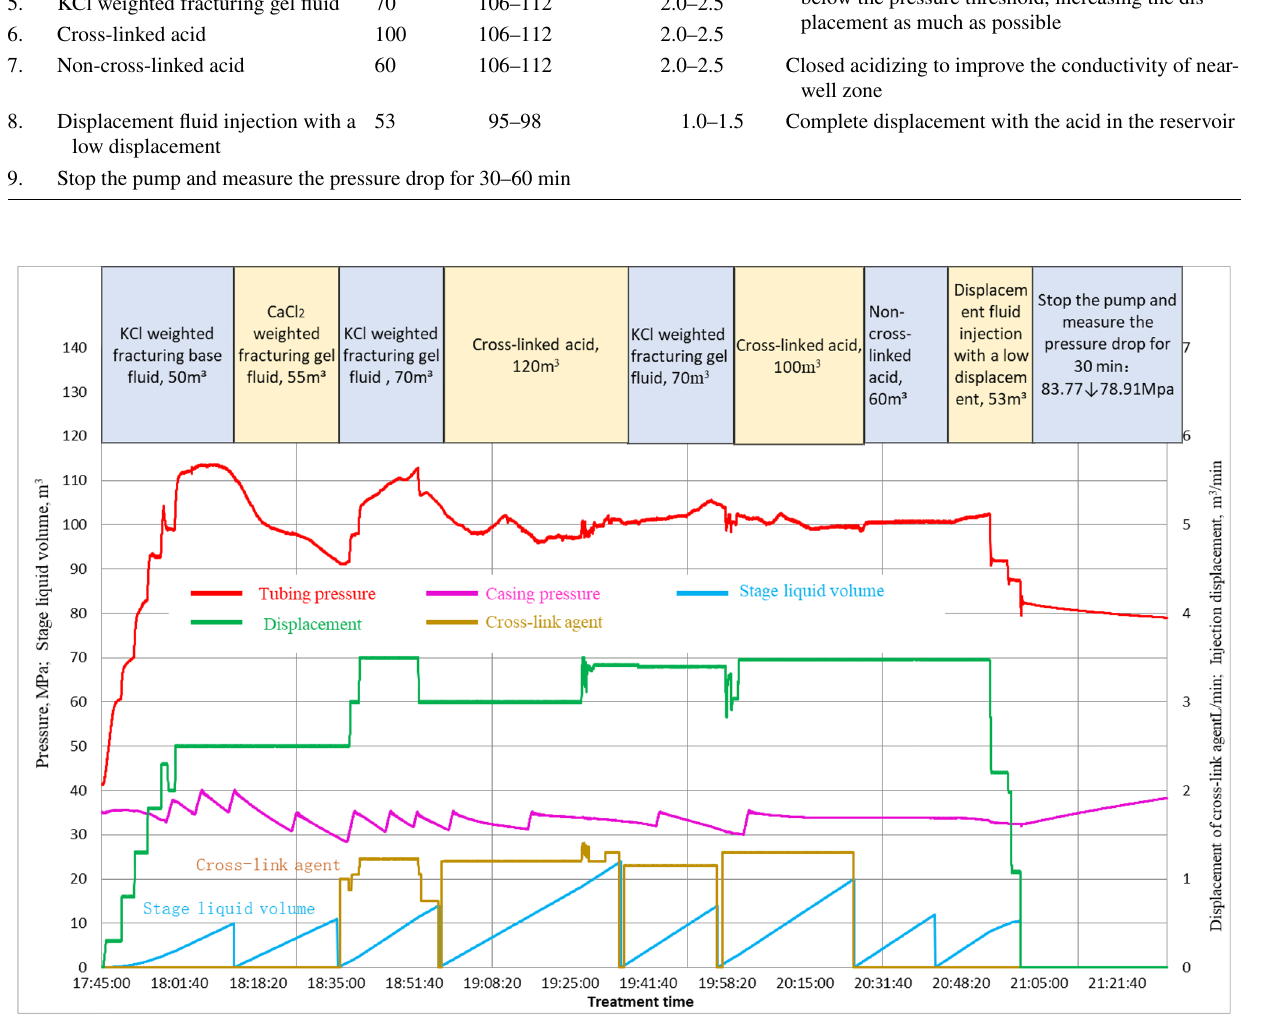
Fig. 10 Pressure profile during treatment injection and displacement